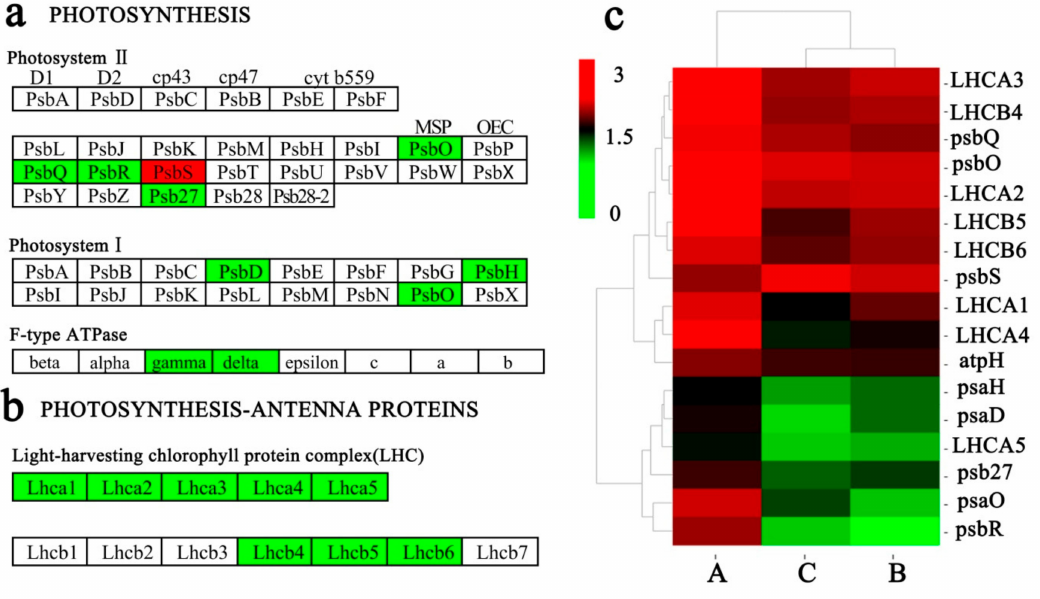
Figure 6. Di ff erentially expressed genes (DEGs) related to photosynthesis pathways in response to low temperature in Camellia oleifera ‘Huaxin’. ( a ) and ( b ) Green and red boxes show the mapped DEGs in the ‘Photosynthesis’ and ‘Photosynthesis—antenna proteins’ pathways, as modified from the KEGG maps (KO 00195 and KO 00196). ( c ) A comparison of the gene expression patterns. Changes in expression level are indicated by a change in color, green indicates a lower expression level, whereas red indicates a higher expression